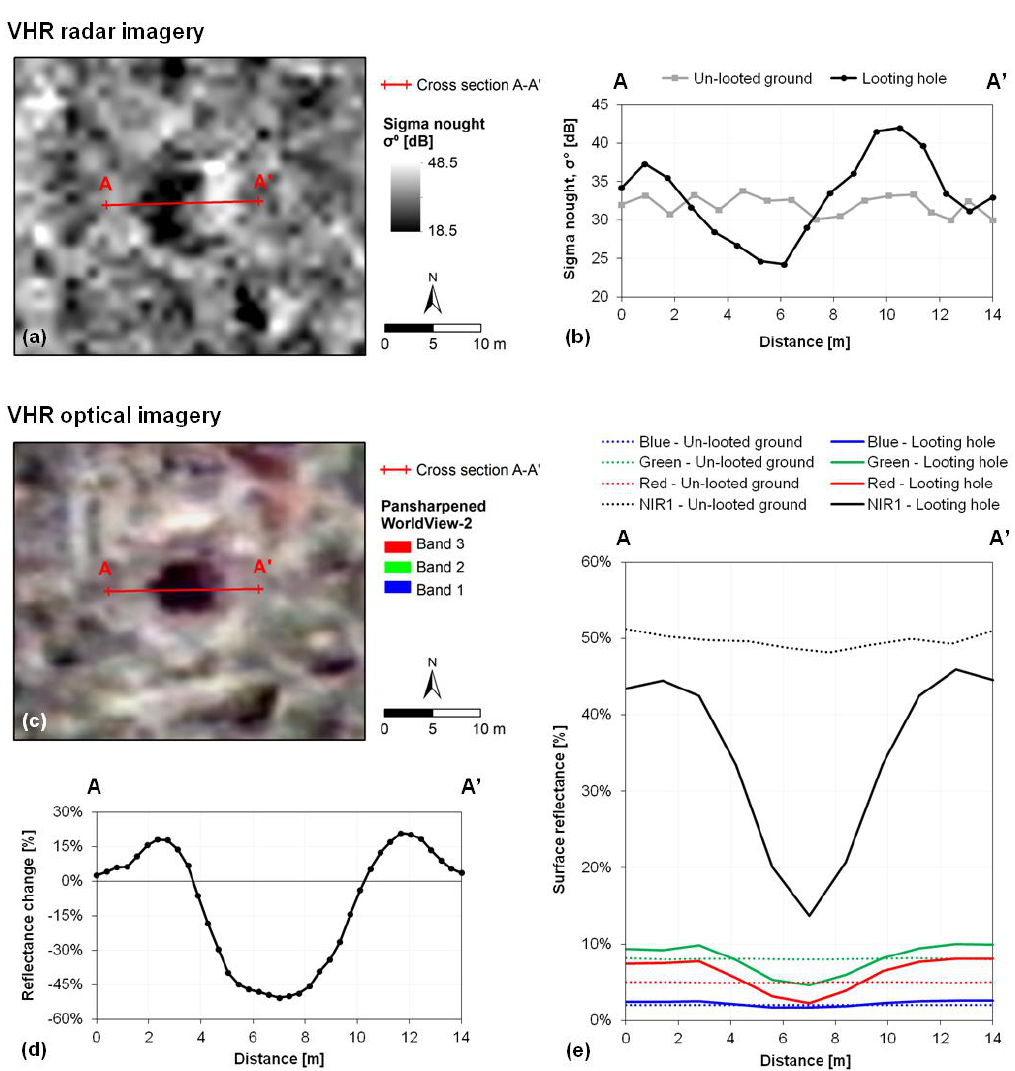
Figure 13. Spectral analysis of a looting hole in Apamea (Syria), compared with un-looted ground: ( a ) COSMO-SkyMed Enhanced Spotlight HH polarized image with 1-m ground resolution acquired in ascending mode, with 41° incidence angle; ( b ) sigma nought ( σ 0 ) profile A-A’ across the looting pit; ( c ) WorldView-2 image pansharpened with Gram-Schimdt algorithm (R: Band 3—red; G: Band 2—green; B: Band 1—blue), ( d ) surface reflectance change in the panchromatic band with respect to un-looted ground, and ( e ) spectral profiles A-A’ across the looting pit. COSMO-SkyMed ® Products ©